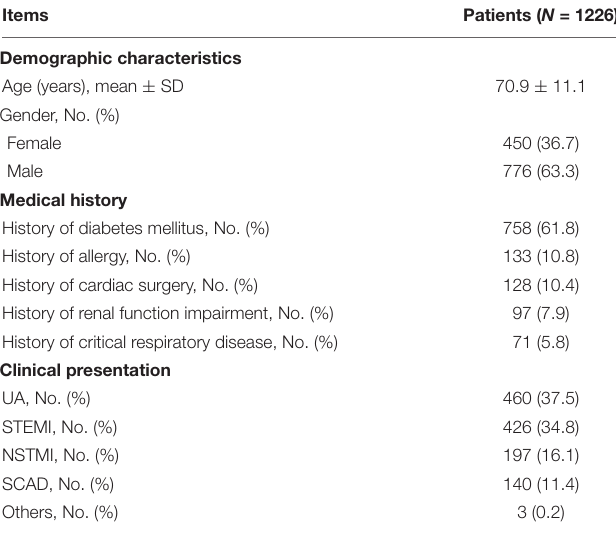
TABLE 1 | Clinical characteristics.